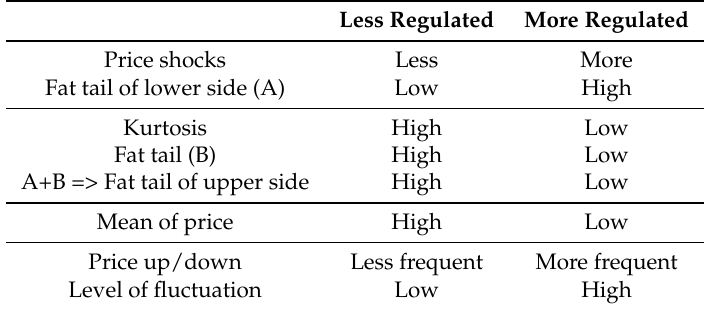
Table 3. Summary of simulated facts and interpretations about the effect of CAR